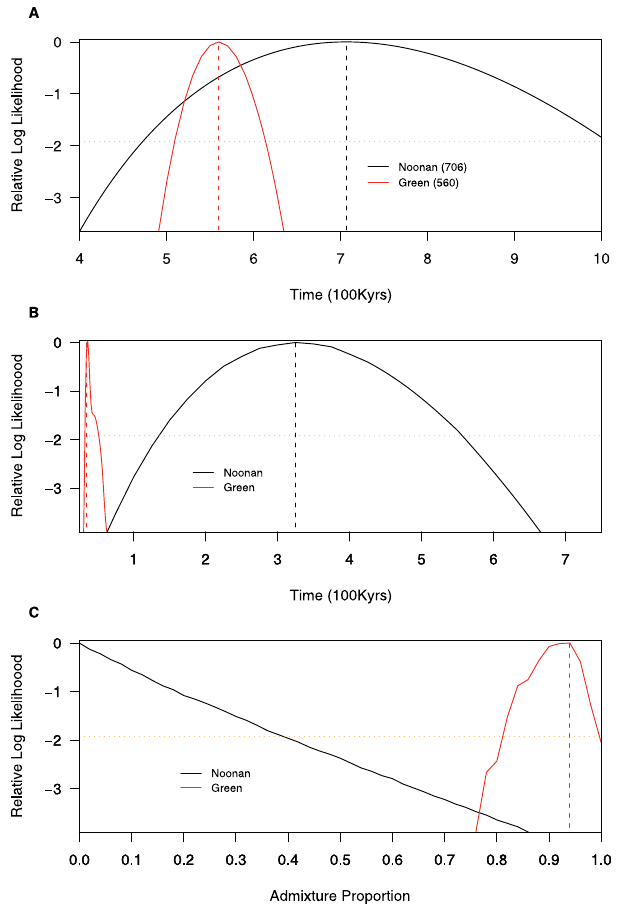
Figure 1. Likelihood Curves for (A) Human–Neanderthal Divergence Time, (B) Modern European–Neanderthal Split Time, and (C) Neanderthal Contribution to Modern European Ancestry for the Noonan et al. (1) and Green et al. (2) Data See Materials and Methods for details.